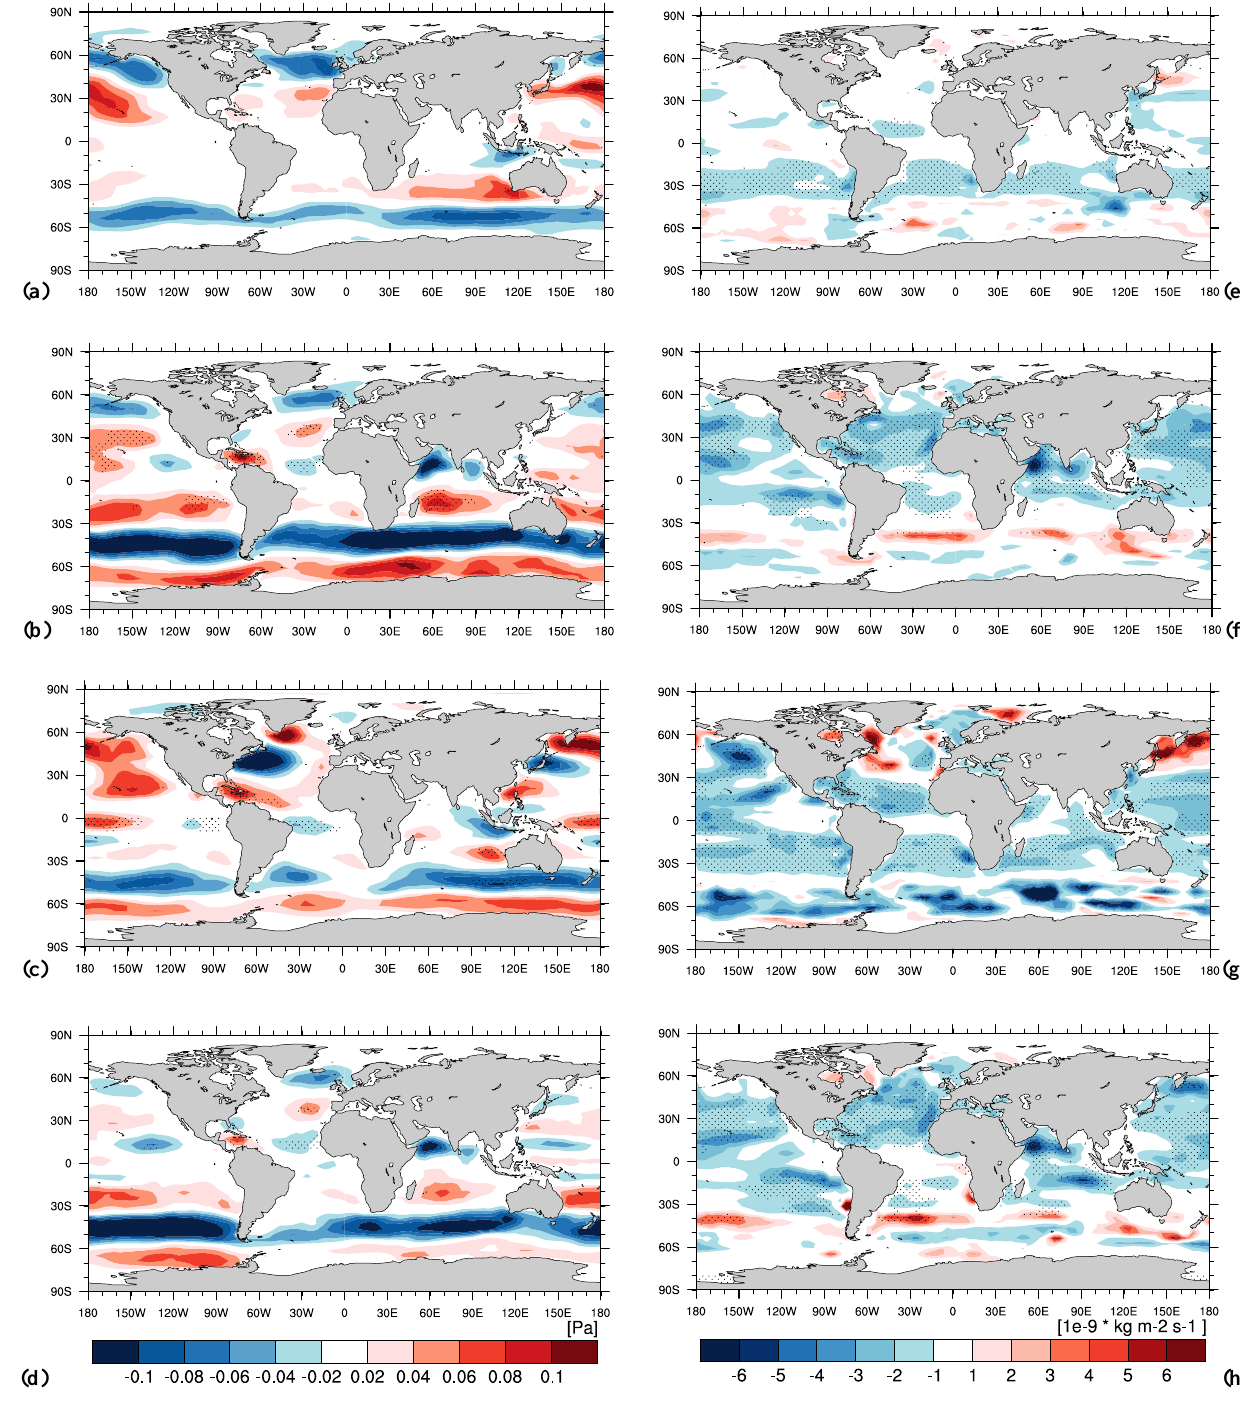
Fig. 5. As Fig. 4, but for (a–d) zonal wind stress τ x (Pa) and (e–f) CO 2 flux (10 − 9 kgCm − 2 s − 1 ) for (a, e) month 12 (December year 1), (b, f) month 18 (June year 2), (c, g) month 24 (December year 2), and (d, h) month 30 of the experiment (June year 3). Positive anomalies of the CO 2 flux indicate an anomalous flux from the ocean to the